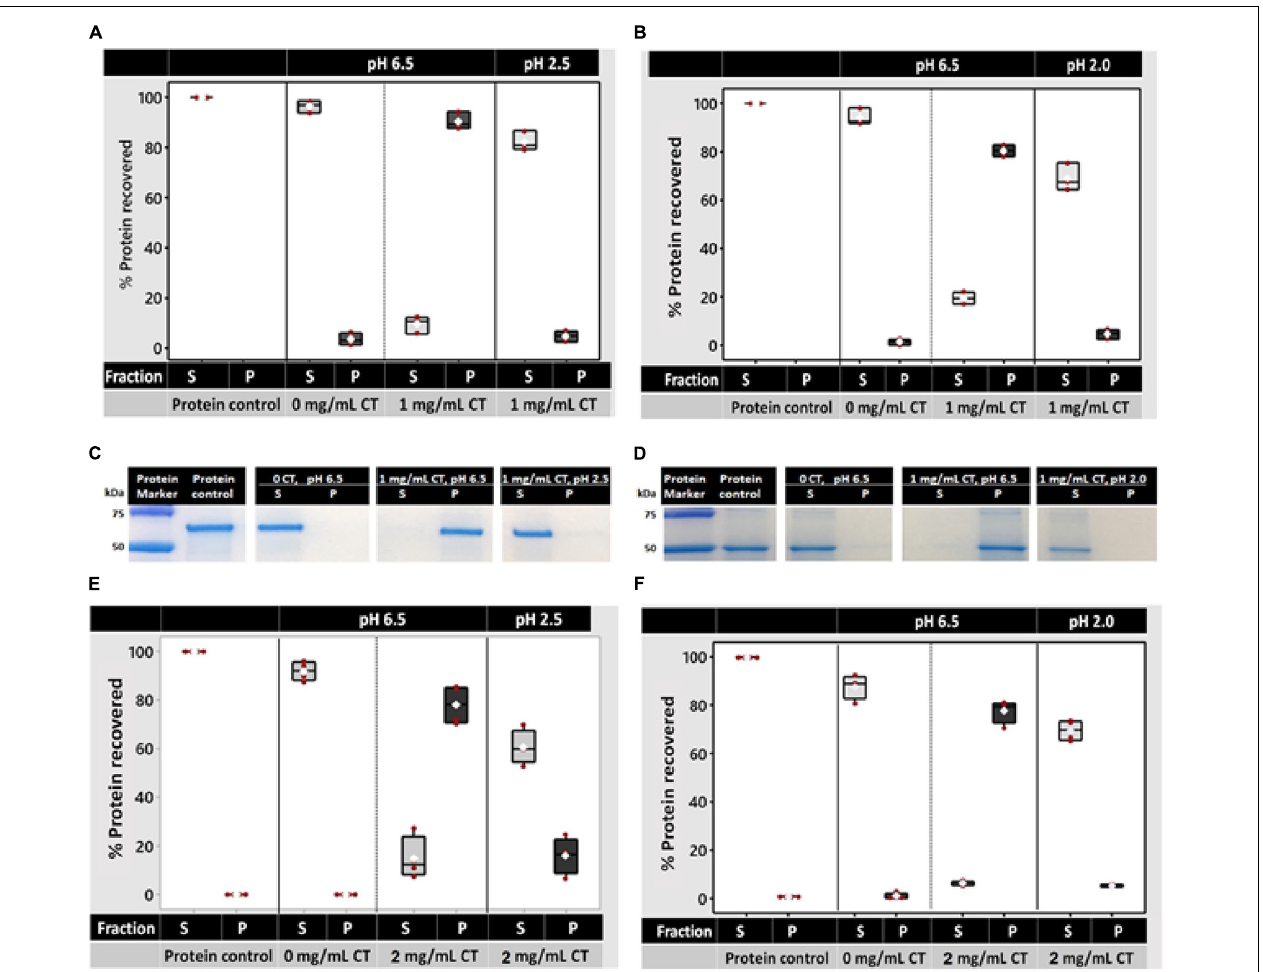
FIGURE 7 | Protein binding and dissociation by white clover leaf CTs and their effects on protein degradation in rumen fluid in vitro . CTs used in protein binding and dissociation studies were either purified by column chromatography (A–D) or used as crude CT extracts from white clover leaves (E,F) . Protein binding was determined by quantifying CT-bound protein in the pellet and residual protein in the supernatant using a Qubit fluorometer (Invitrogen). (A,B) Protein binding by CTs (1 mg/ml) at pH 6.5 (rumen pH) and dissociation at pH 2.5 (for BSA) or pH 2.0 (for white clover protein; abomasum pH). (C,D) Representative SDS-PAGE gel showing protein partitioning between the supernatant or pellet after 20 min of incubation with 1 mg/ml of column-purified white clover leaf CTs from CTG-T 0 . The protein marker was the Precision Plus Protein Standard™ (Bio-Rad). (E,F) Protein binding by crude CT extracts (2 mg/ml) at pH 6.5 and dissociation at pH 2.5 or pH 2.0. In panels (A–D) , purified CTs from CTB-T 0 , CTF-T 0 , and CTG-T 0 were used as biological replicates. In panels (E,F) , four independent CT extractions (two T 2 plants, each with 2 clones) served as biological replicates. Each data point in panels (A,B,E,F) represents a biological